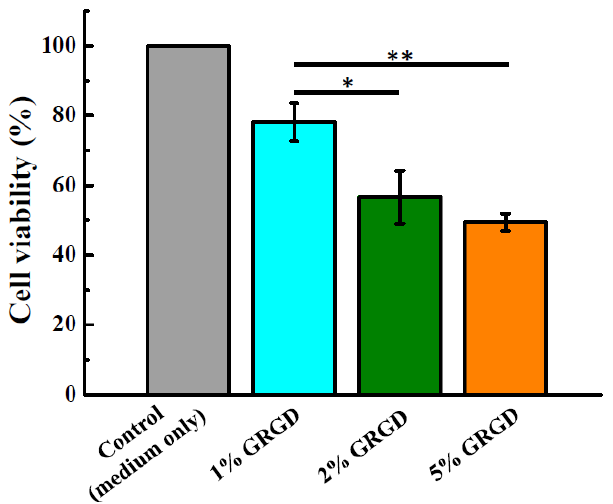
Figure 3. Effect of the GRGD peptide, with different concentrations, on the viability of L929 cell evaluated by 3-[4,5-dimethylthiazol-2-yl]-2,5-diphenyltetrazolium bromide (MTT) assay. (* p < 0.05 and ** p <